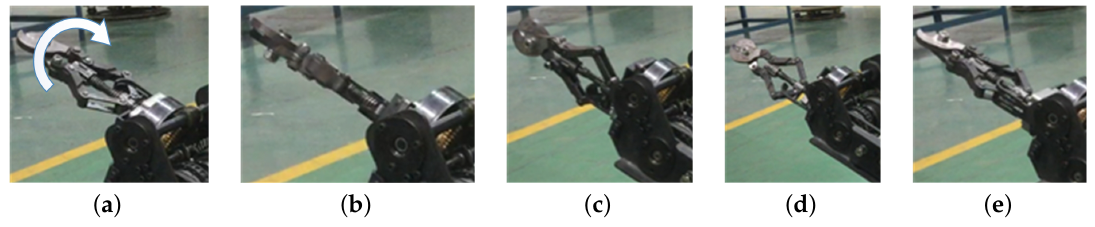
Figure 28. ( a – e ) show the process of the scissors rotating 360 deg counterclockwise, which is driven by the wrist joint